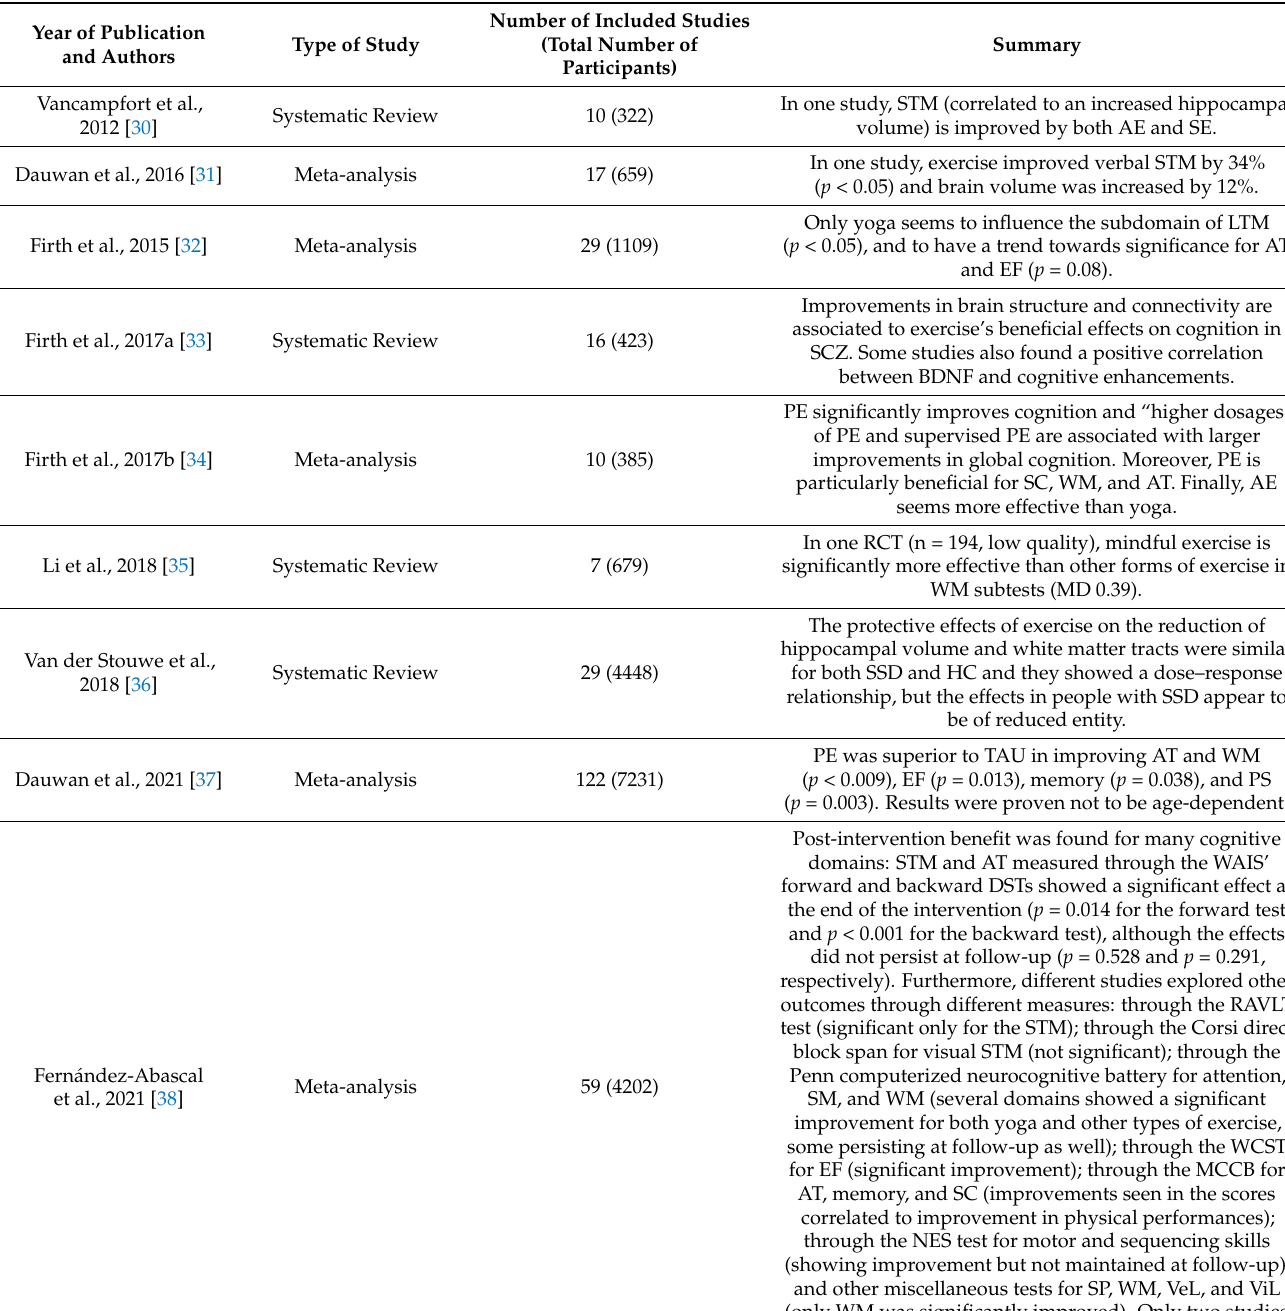
Table 1. Studies on the effect of physical exercise on cognition in